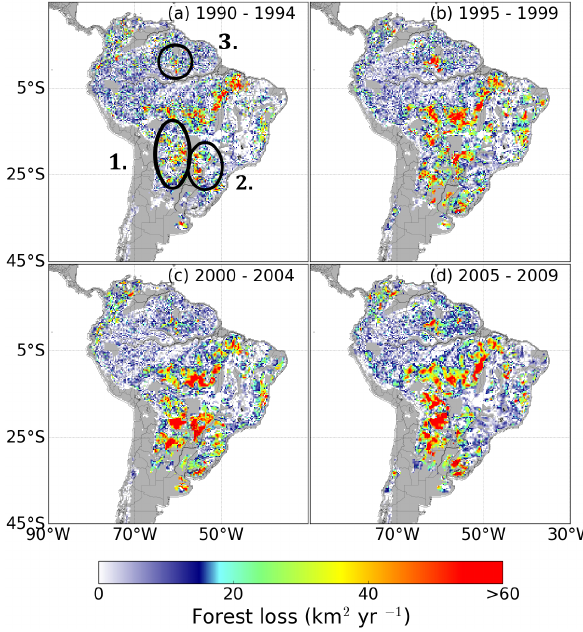
Figure 3. Forest loss extent based on the VOD outliers for the 5-year epochs. Grey areas are masked out (Fig.